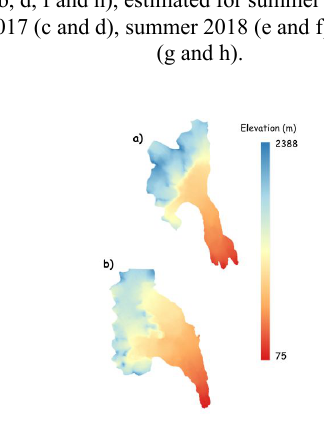
Figure 8. Elevation of Grey (a) and Tyndall (b) glaciers.